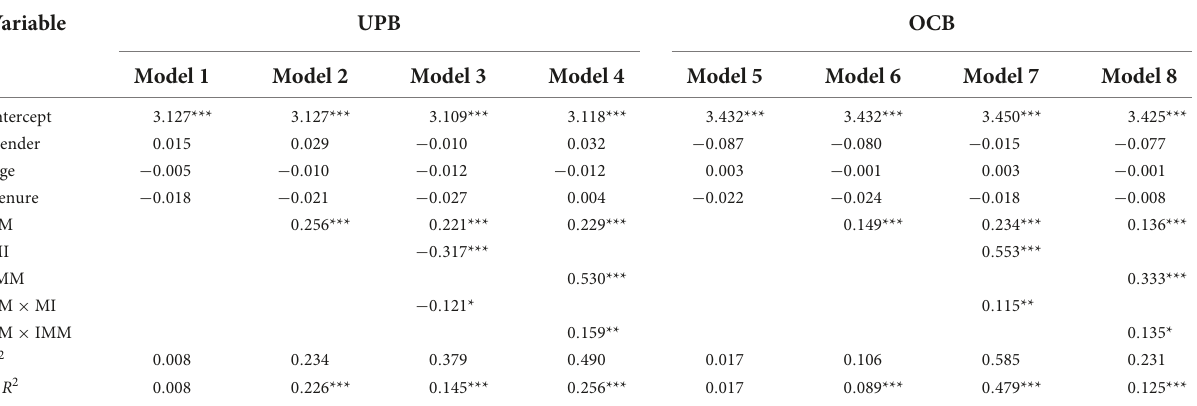
TABLE 3 The results of hierarchical regression